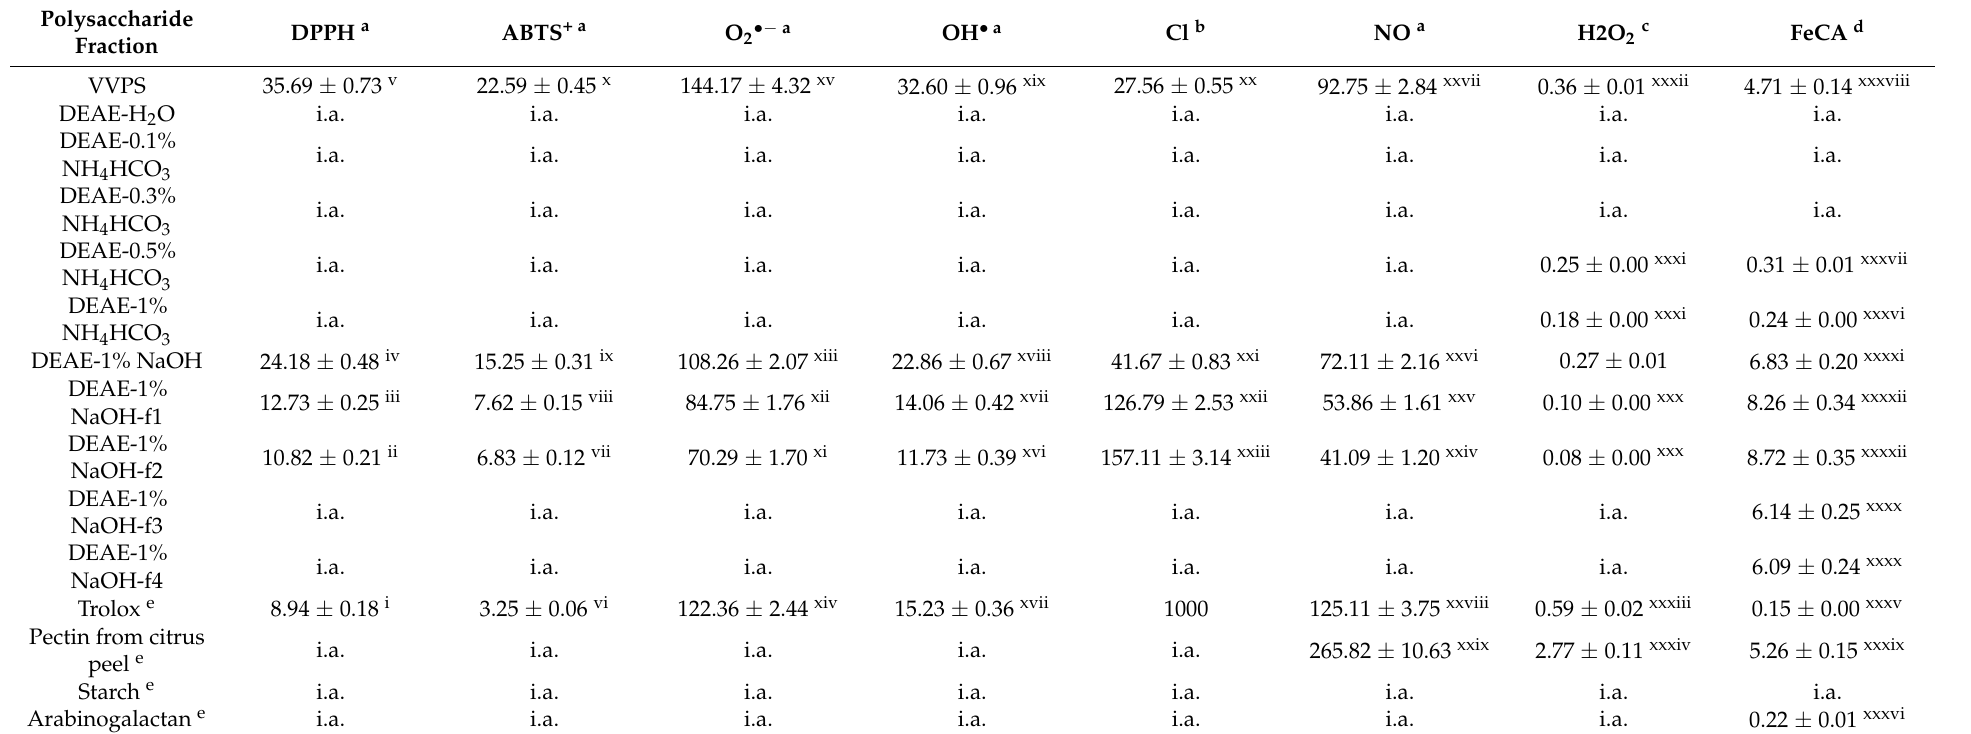
Table 4. Antioxidant activity of VVPS, DEAE–cellulose and DEAE–sepharose fast-flow gel fractions ( n =